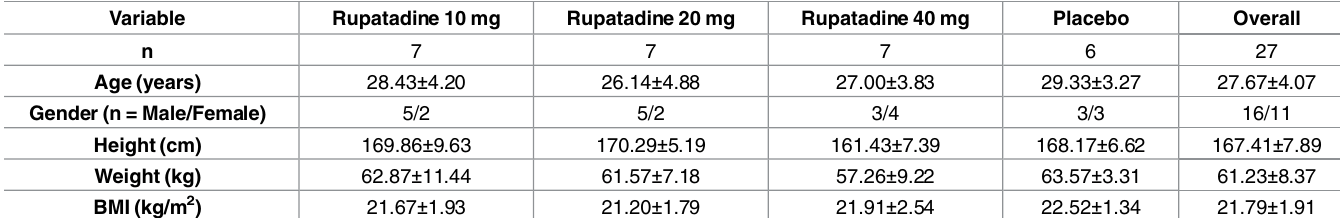
Table 1. Demographic characteristicsof